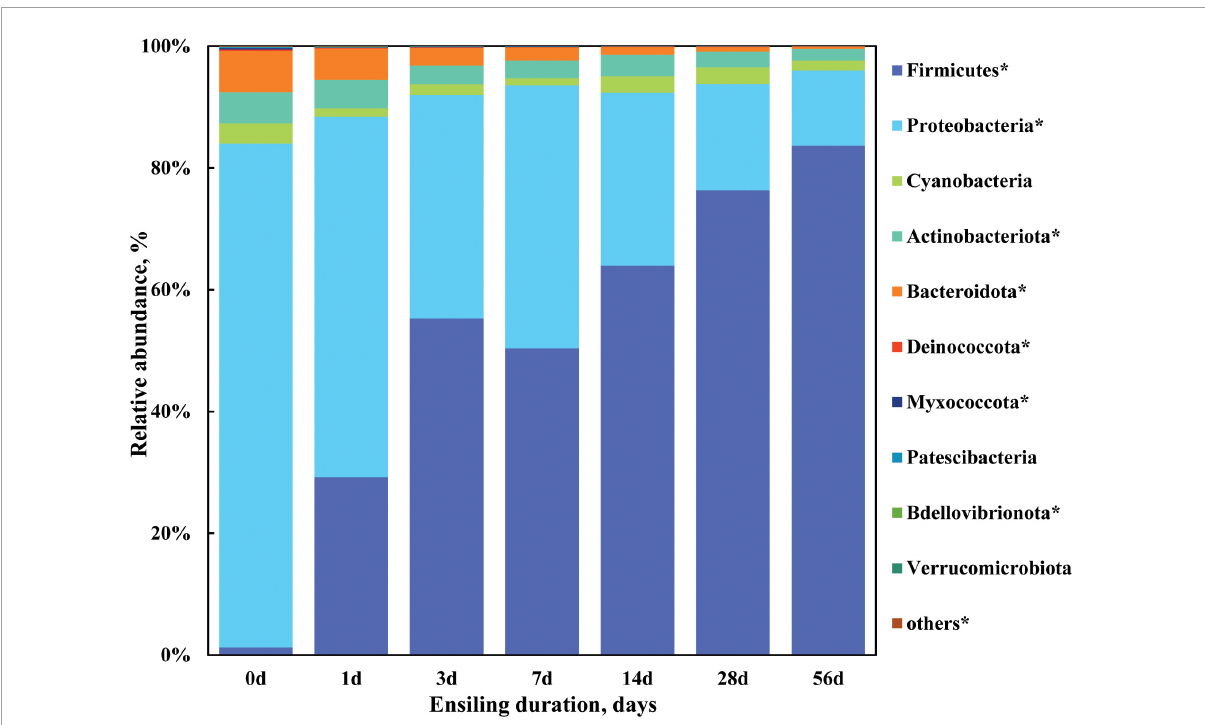
FIGURE2 Dynamic changes of the bacterial composition at the phylum level in the sorghum stalk silage with ensiling duration. Taxa name with asterisk (*) denoted highly significant ensiling duration effect ( P < 0.01).